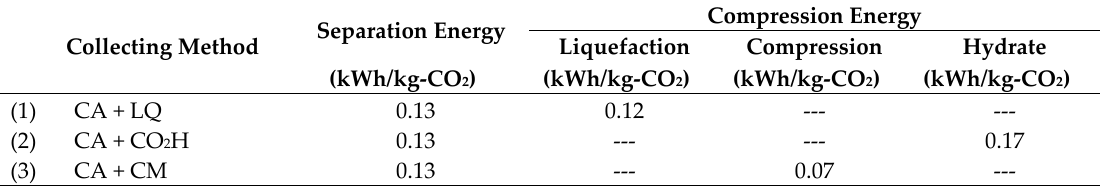
Table 7. Separation and boosting energies required for each method.